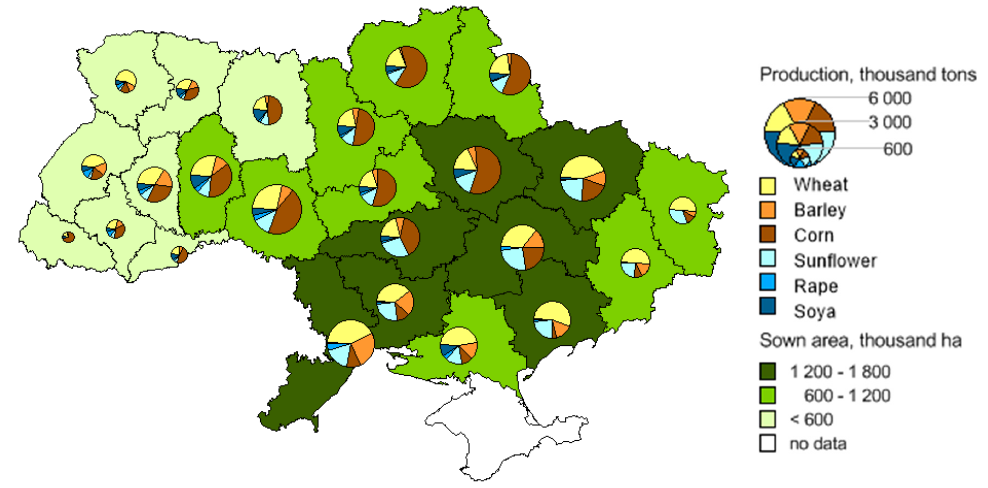
Figure 2. Sown areas and production volumes of main crops in Ukraine (based on 2017 data). Source: own compilation based on [51].